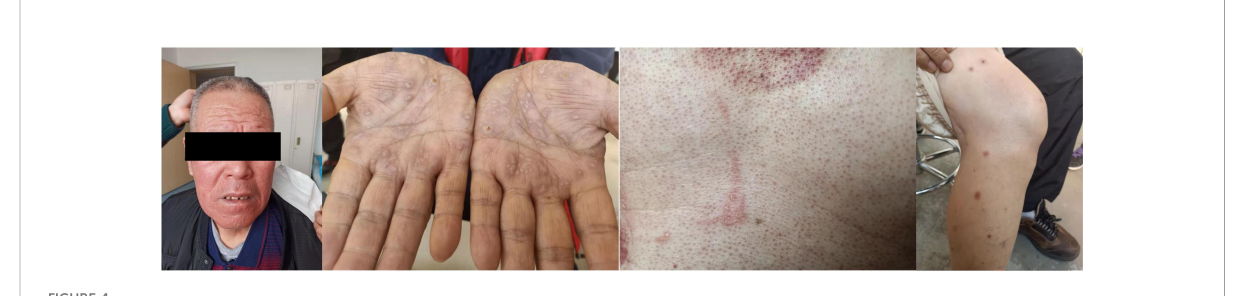
FIGURE 4 Rash after targeted